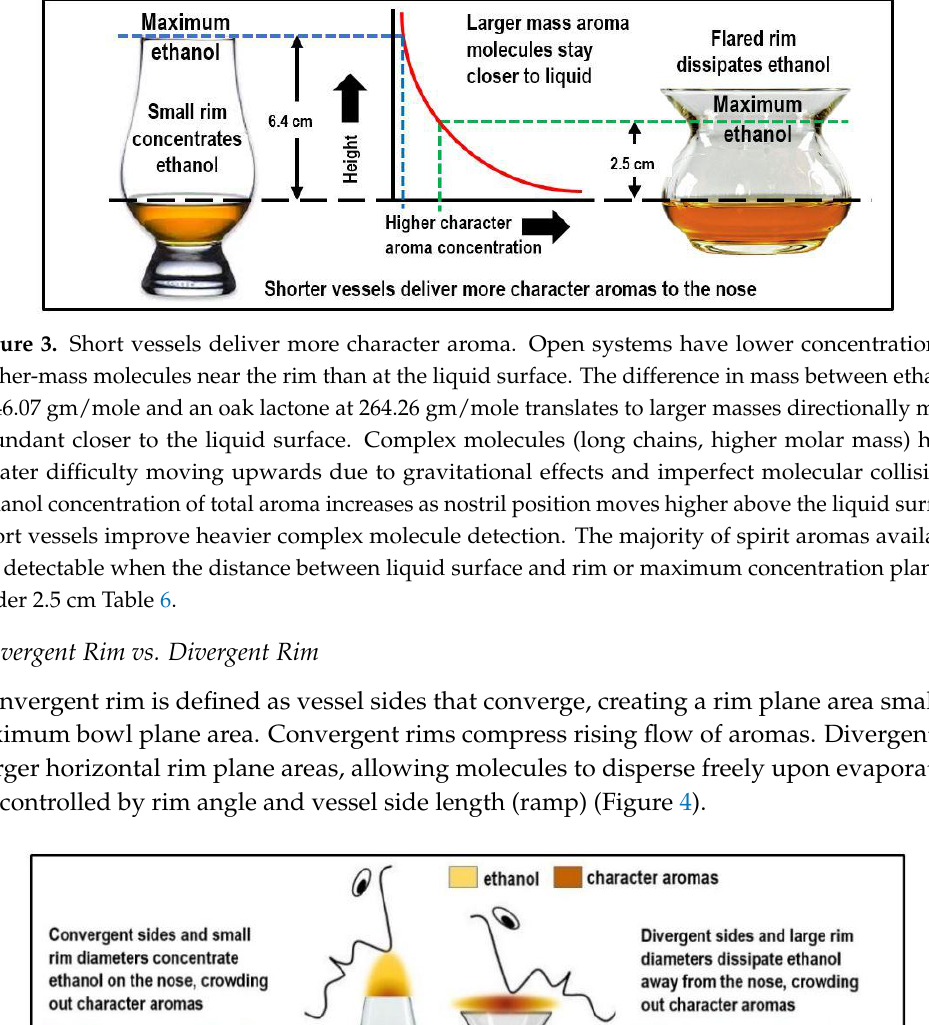
Figure 5. Advantages of combining two shapes. Large convergent vessel bowl improves swirling evaporation, ensuring that more aromas reach the orifice or neck, to be diffused by the divergent expansion chamber. Orifice height of the engineered vessel is well below 2.5 cm. 2.7. Application of Gas Kinetic Theory and Graham’s Law Applying gas kinetic theory explains the ethanol separation process: 1. Convergent sides concentrate molecules increasing collisions and small molecule velocities. From the kinetic energy equation: 𝑣 𝑝 = √2 𝑘 𝐵 𝑇 𝑚 , where 𝑘 𝐵 = Boltzmann constant, T = temperature 0 𝐾 . (1) Particle velocity is inversely proportional to the square root of its mass. Convergent bowl increases molecular flux and impingement rate at the orifice, imparting higher velocities to lower mass molecules, especially lowest mass and highly abundant ethanol. 2. Divergent sides allow dissipation. Applying Graham’s law to compare diffusion rates of two gas components, the equation becomes: 𝑅𝑎𝑡𝑒 1 𝑅𝑎𝑡𝑒 2 = √ 𝑀 2 𝑀 1 . Substituting an arbitrary diffusion Rate 2 = 1.00, and a molar mass of 46.07, to represent ethanol, the aroma diffusion rates of other aroma molecules are calculated as a percentage of the fastest diffuser, ethanol (1.00).